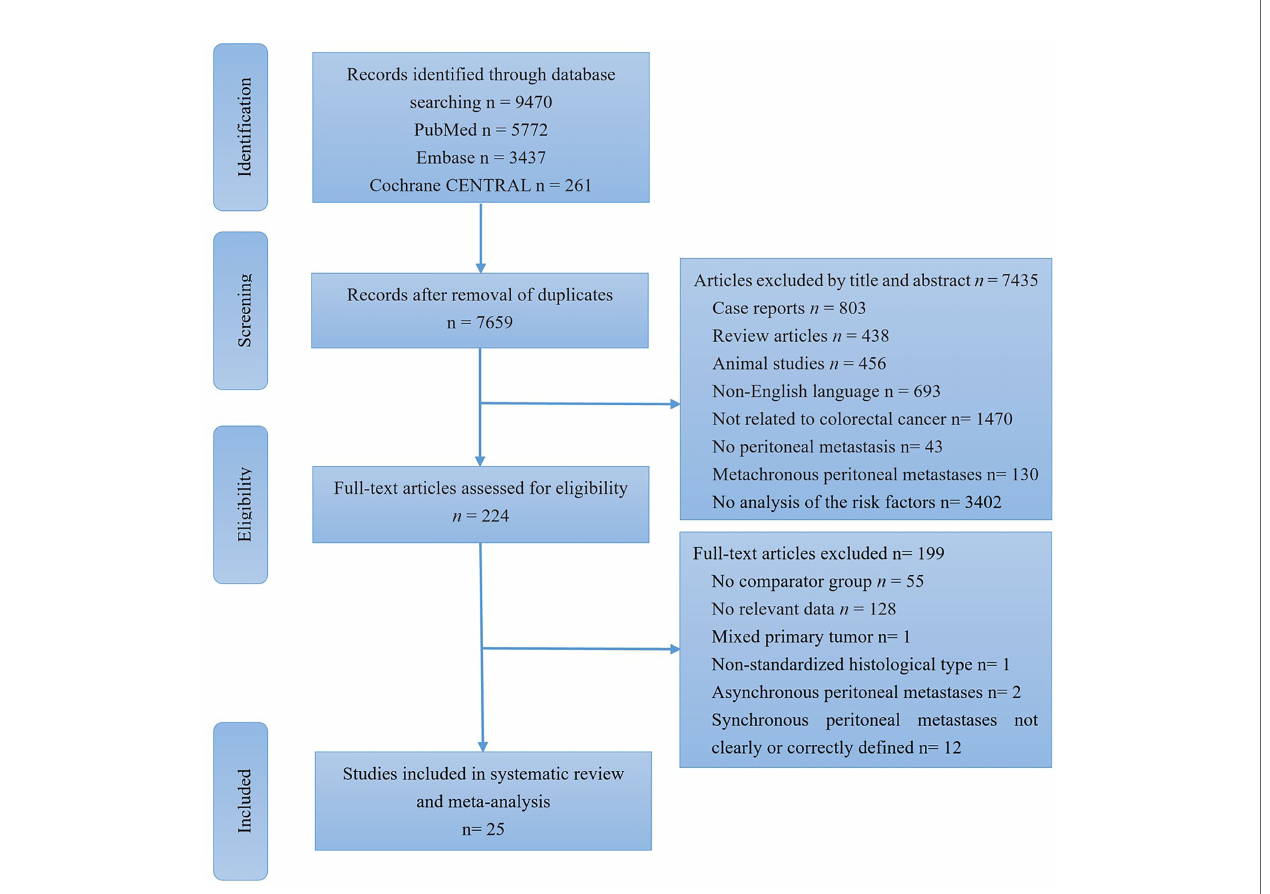
FIGURE 1 | Flow diagram showing the search and selection of